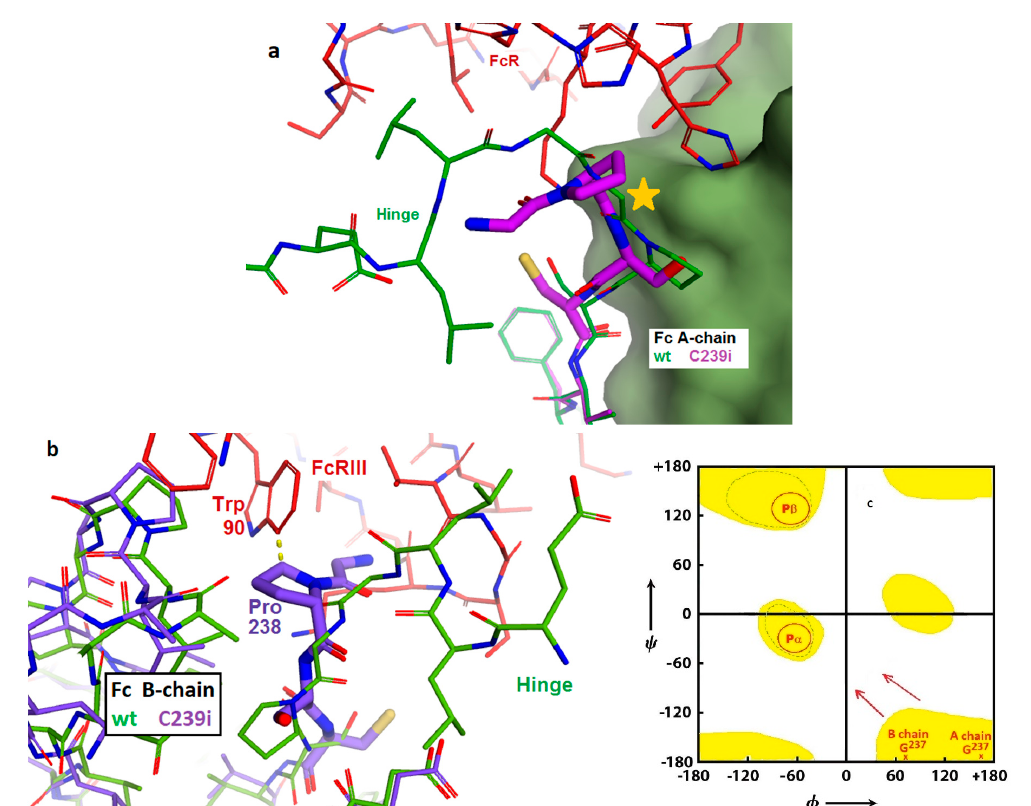
Figure 5. Structural basis for prevention of antibody-dependent cellular cytotoxicity (ADCC) through loss of Fc γ RIIIA binding. ( a ) Superposition of Fc-C239i (purple) onto the Fc-wt (green) in its complex (PDB: 3ay4) with the Fc γ RIIIA receptor (red) in the area of the insertion in the A-chain. The inserted cysteine is just below the center. The star indicates the location of the highly extended Gly 237 in Fc-wt, which is occupied by Pro 238 in the mutant. The proline is unable to adopt the glycine’s extended conformation, changing the path of the polypeptide and disrupting the interface. ( b ) As with the A-chain in Figure 4a, the B-chain interface is likewise disrupted by the inability of Pro 238 to conformationally replace Gly 237. In addition, the location of Trp 90 in the 3ay4 complex is within 0.3 nm of the popped-up proline (dashed line), causing further destabilization of the interface. Colors are given as in ( a ). ( c ) Ramachandran diagram showing energetically-allowed regions for glycine (yellow) and for proline (red circles). The Fc-wt A-chain and B-chain locations of Gly 237 are shown at the lower right; proximity to the corners correlates with their extended conformation as observed in the 3ay4 complex. The arrows indicate that when proline displaces glycine, the conformation is forced to change. Due to steric constraints from adjacent parts of the Fc, both prolines are forced into the sharply bent P-alpha conformation, disrupting receptor